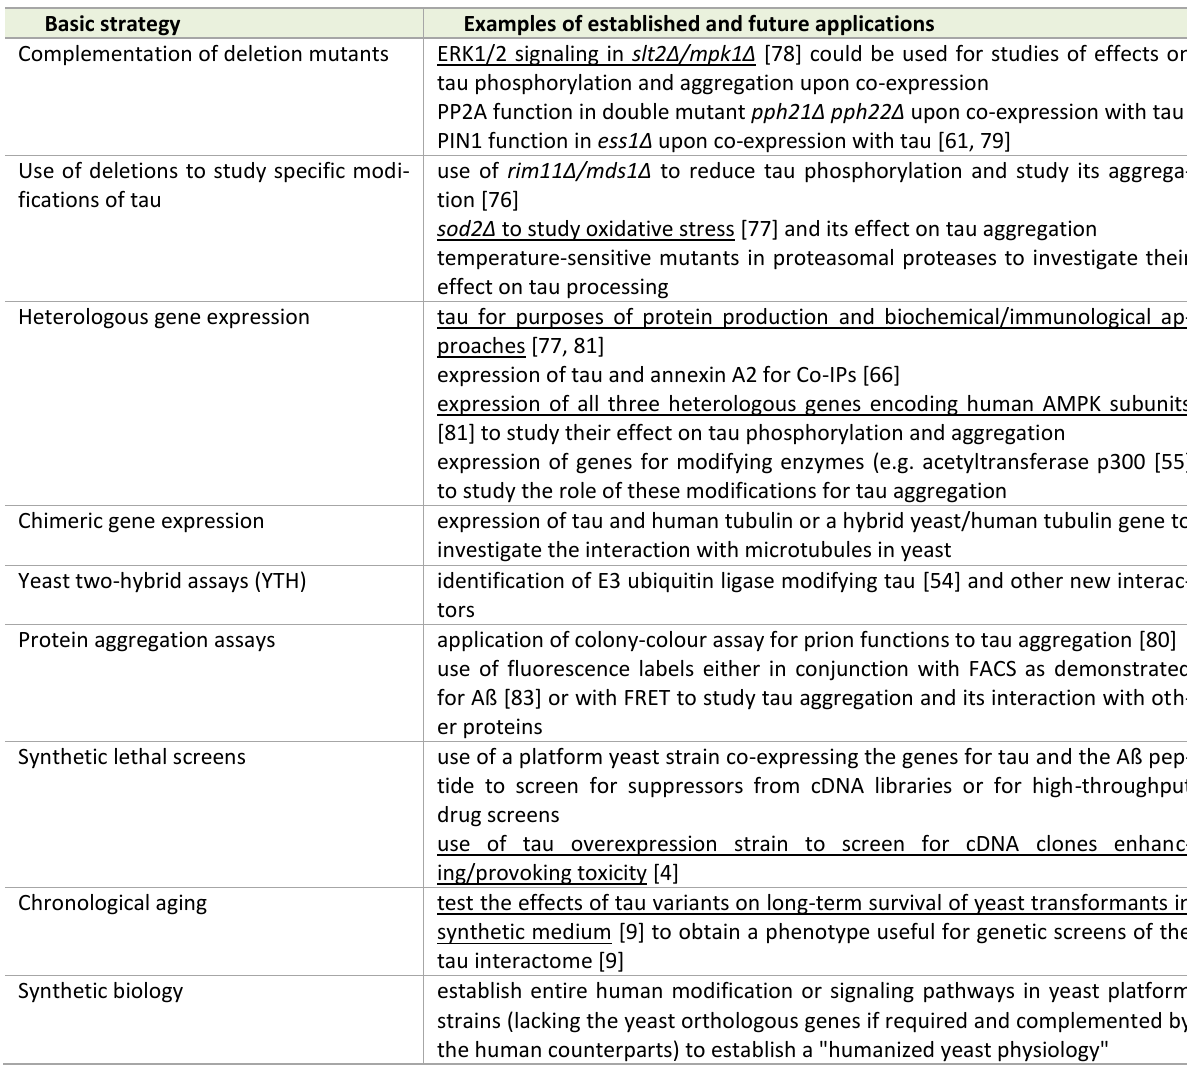
TABLE 1. Basic approaches to study aspects of tau biology in S. cerevisiae* Basic